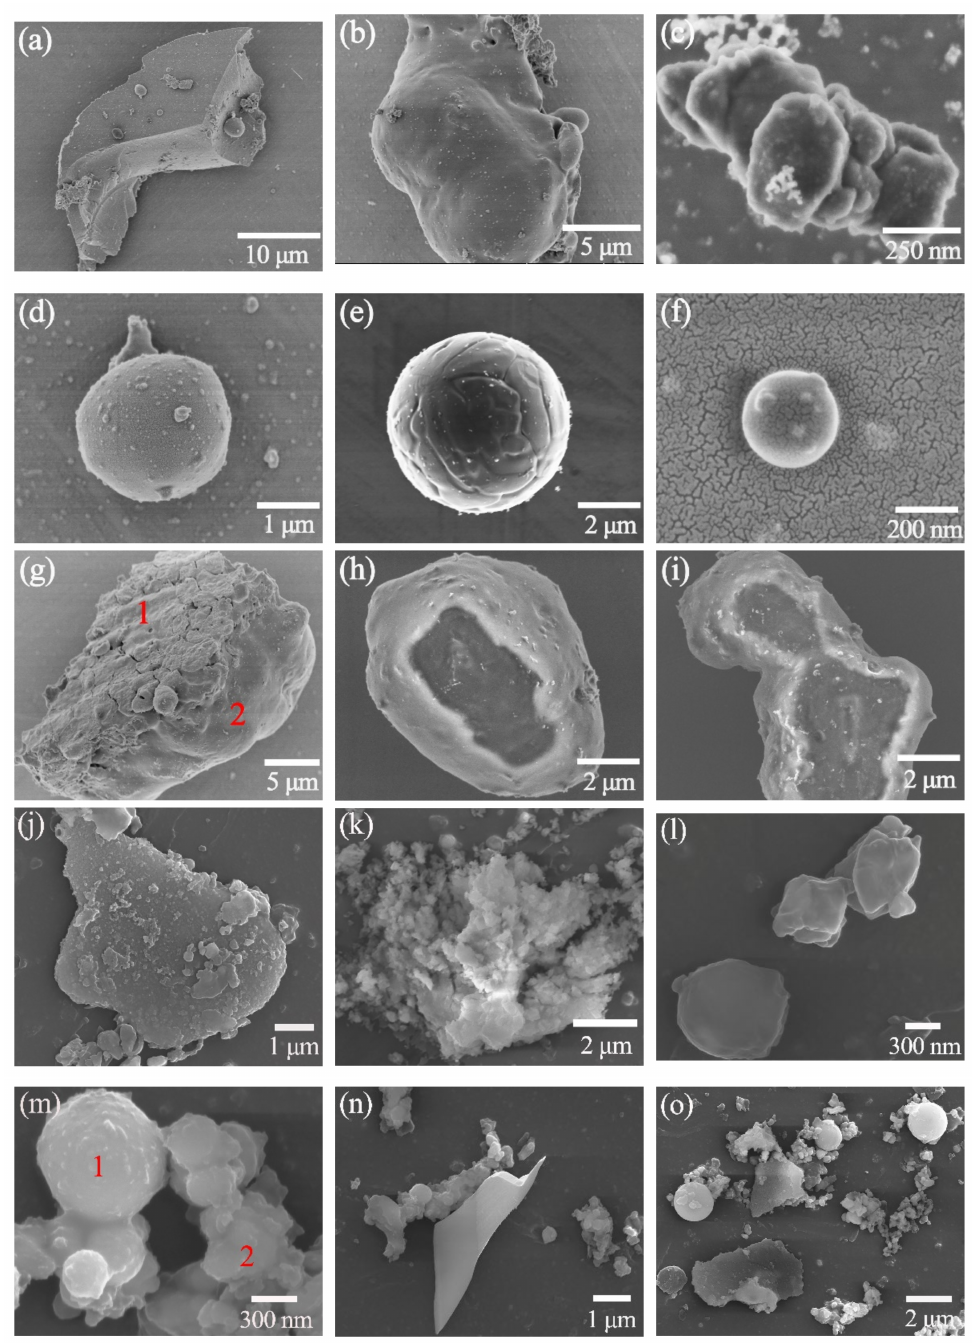
Figure 15. SEM images of particles collected by silicon wafer: ( a – g ) in ambient air, defocus distance 0 mm; ( h ) in ambient air, defocus distance +3 mm; ( i – l ) in inert atmosphere, defocus distance is 0 mm; ( m – o ) in inert atmosphere, defocus distance +4